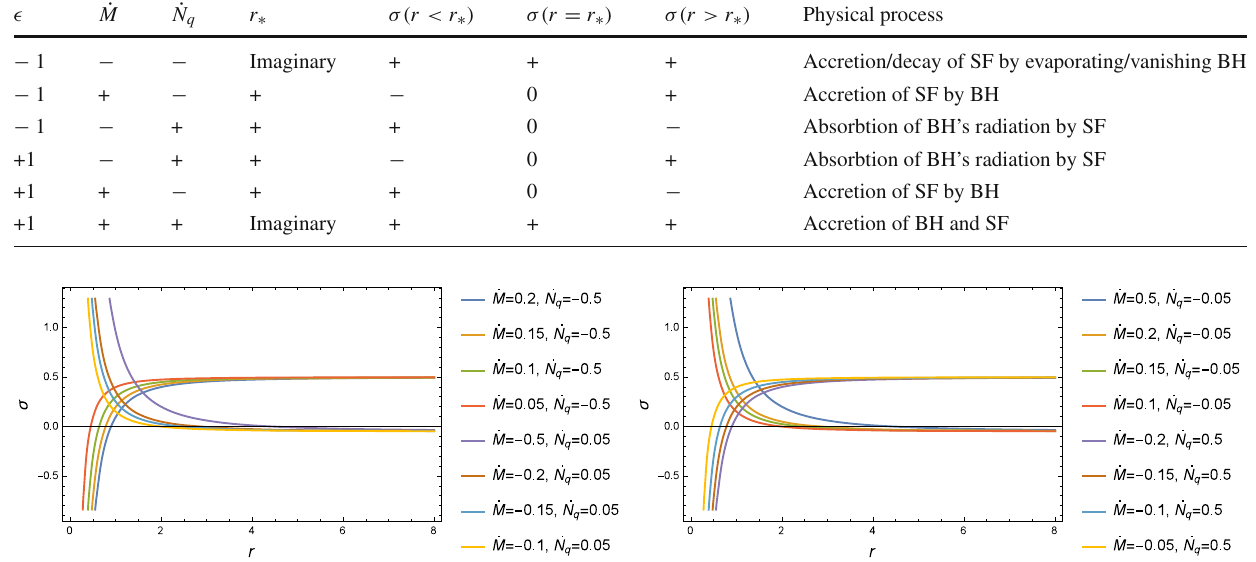
spacetime. Right figure: the radiation-accretion density σ versus the distance r for some typical constant ˙ M and ˙ N q values for (cid:5) = + 1 in the quintessence background. In the upper panel, the accretion den- sity is a decreasing function from positive to the negative values. In the lower panel, the radiation density is an increasing function from negative values to positive values. Then, for a dynamical quintessence background, if the condition | ˙ N q ( u ) | (cid:11) | ˙ M ( u ) | is not met, the positive energy condition is violated in some regions of